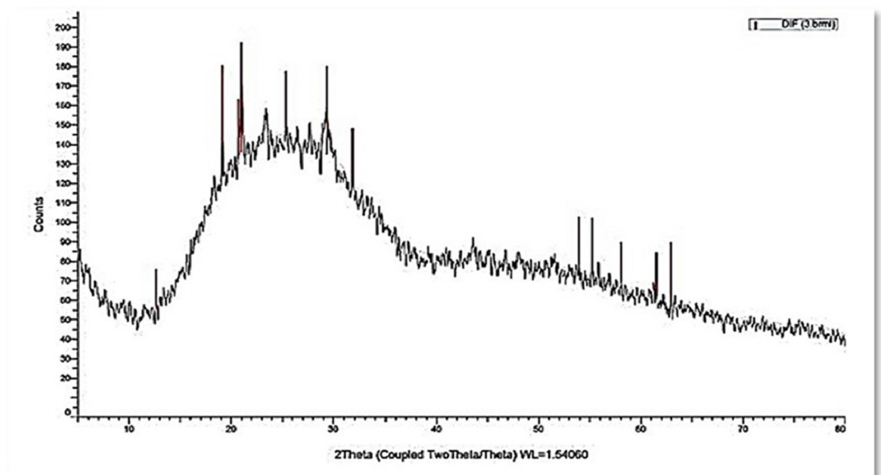
Figure 4. XRD spectrum of myco-synthesized selenium nanospheres.